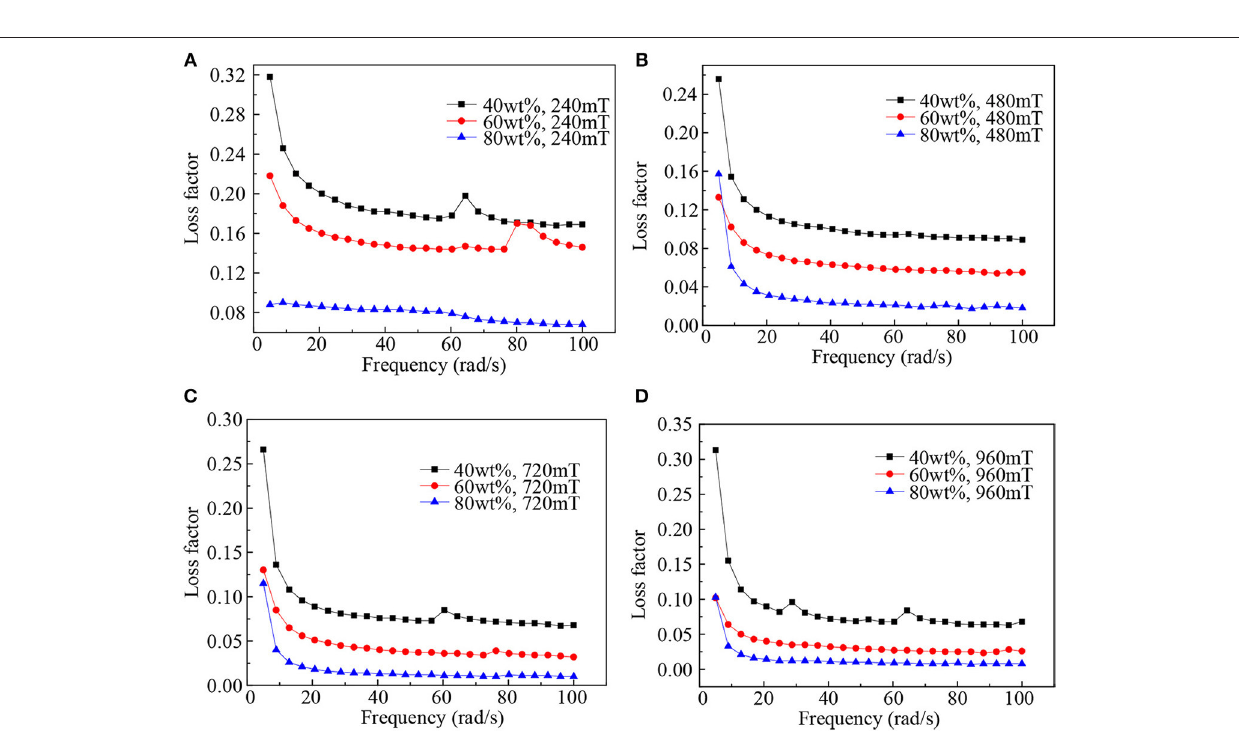
Frontiers in Materials |